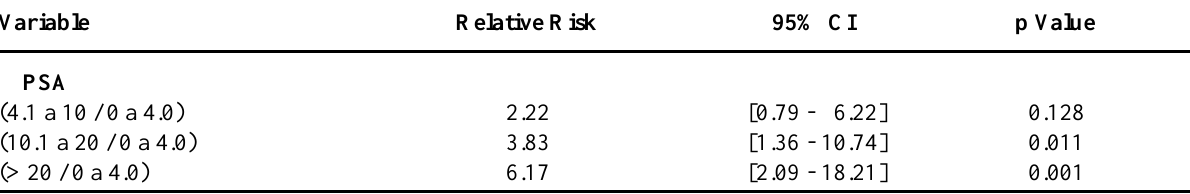
Table 4 – Analysis of relative risk for PSA in Cox Regression Model. Variable